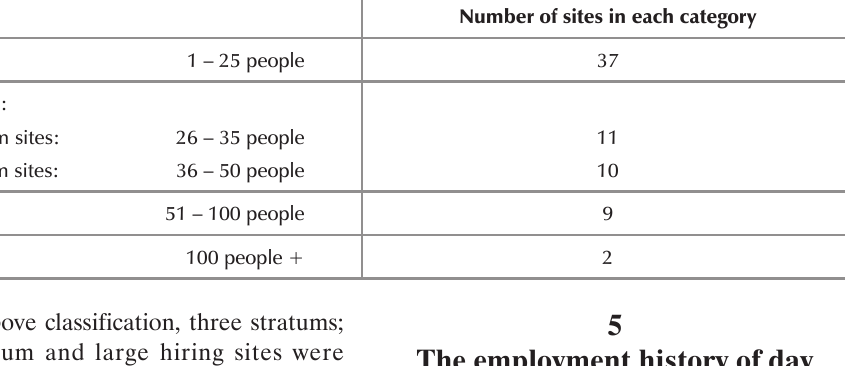
Classification of hiring sites according to size and site number Number of sites in each